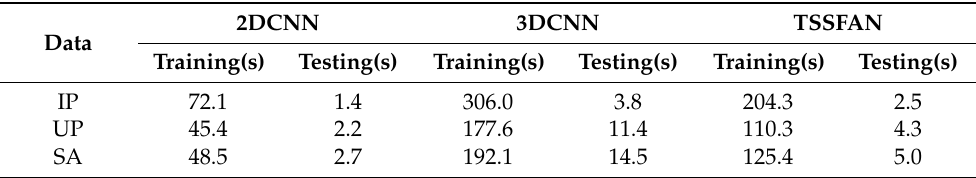
Table 8. Computational efficiency of 2DCNN, 3DCNN, and TSSFAN on the three HSI datasets. 2DCNN Data